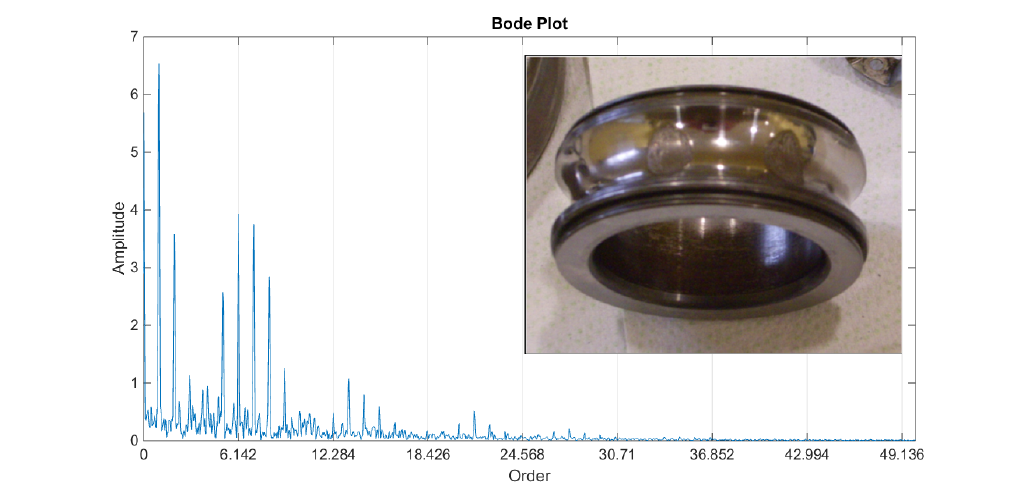
Figure 4. Example of the model-based technique output for condition monitoring. Order tracking and demodulation of the vibration signal reveal the presence of a fault in the inner ring of the